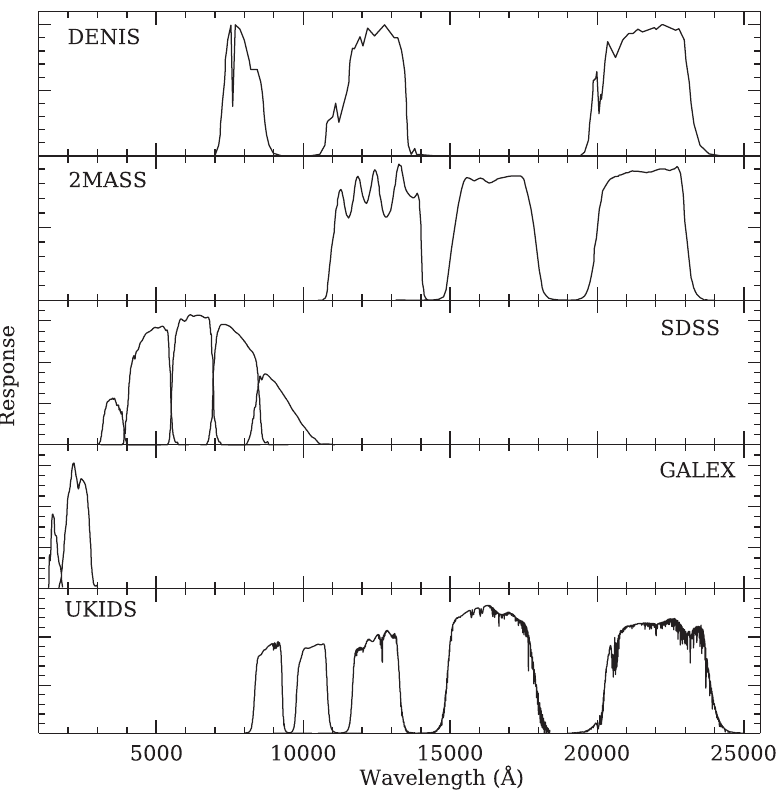
Fig. 2. Response curves of the analyzed